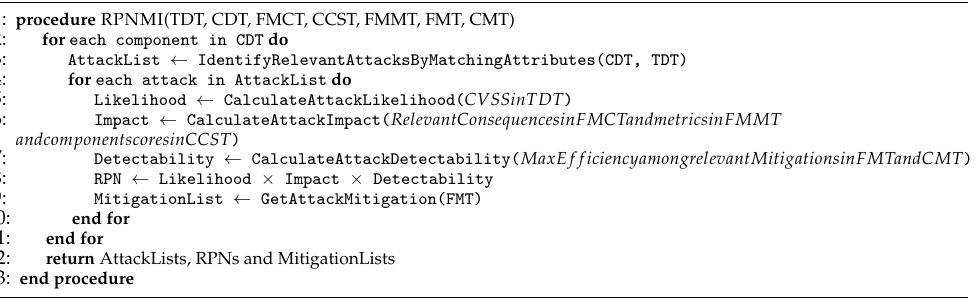
Algorithm A1 Risk Priority Number (RPN) Calculation and mitigation identification (RP- NMI) (adapted from [12]). Check Table A1 for